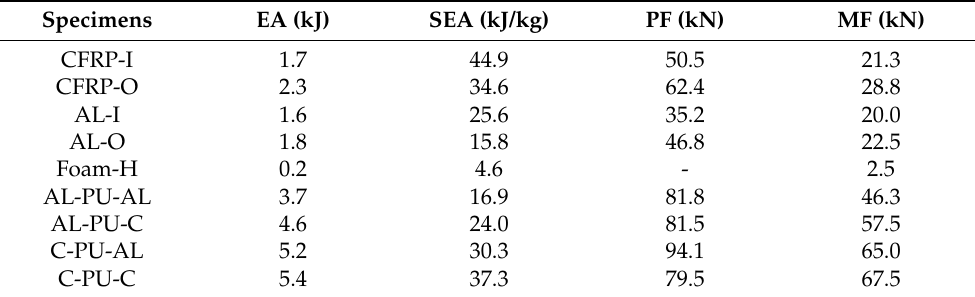
Table 3. Summary of crashworthiness indicators of single tubes and hybrid structures obtained from the experimental